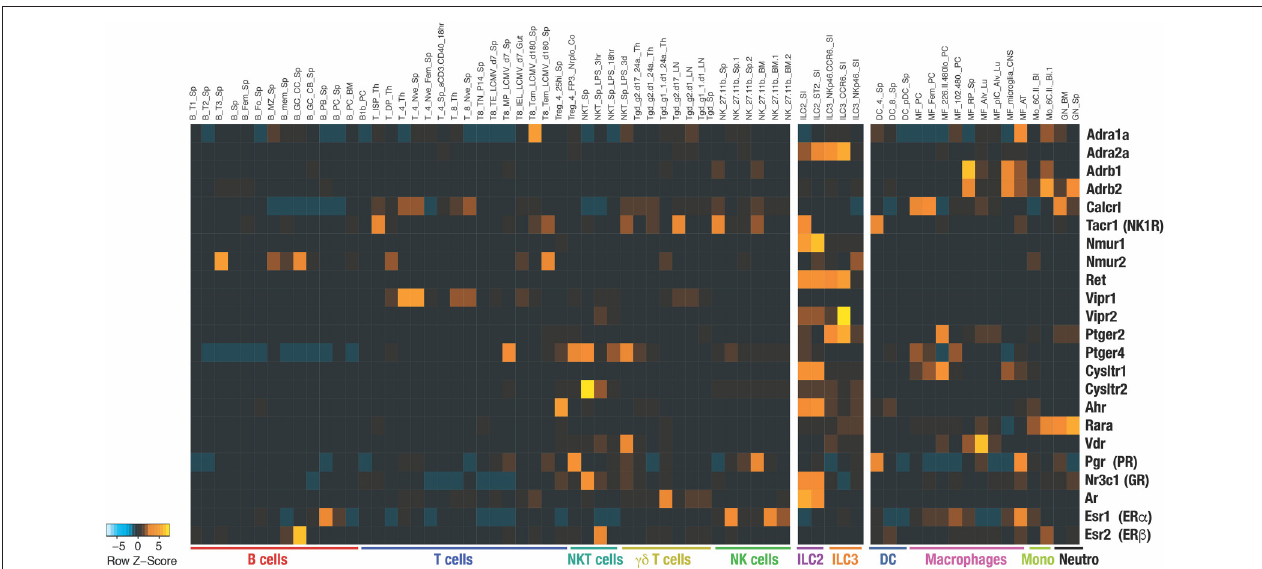
FIGURE 1 | Heatmap shows the RNA expression of the indicated receptors among different immune populations. The data have been extracted from Immunological Genome Project (https://www.immgen.org) ( 4). Name of each population extracted from ImmGen database are indicated on top of the heatmap.